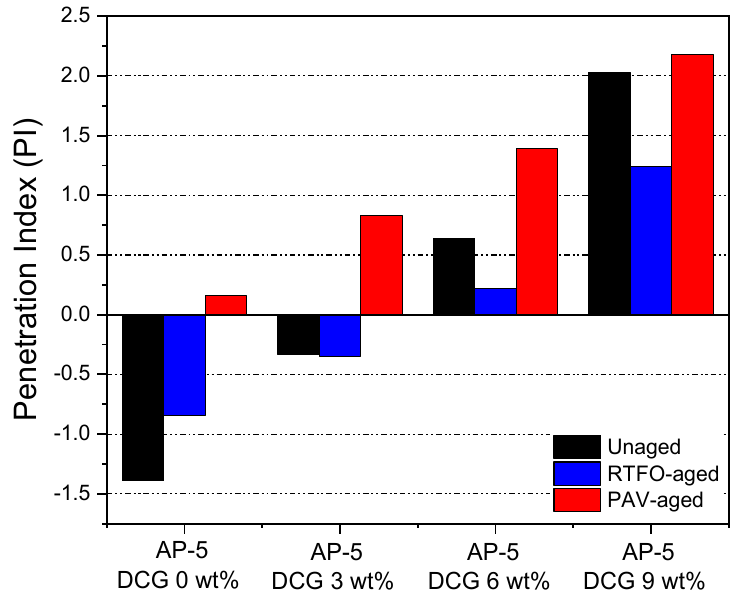
Figure 10. Influence of various fractions of DCG (e.g., 3, 6, 9 wt%) on the penetration index (PI) of base AP-5 asphalt before and after RTFO and PAV aging.